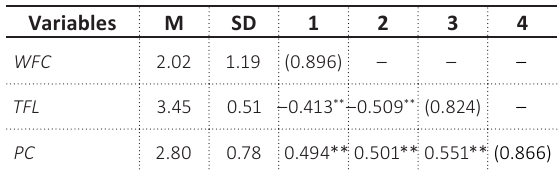
Table 2. Means, SD, reliability, and correlation of the study variables